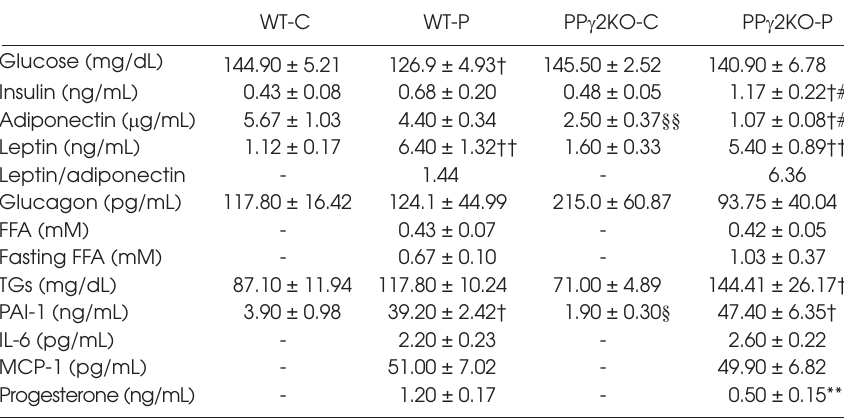
Table 2. Serum metabolic parameters measured under fed conditions on d 18 of